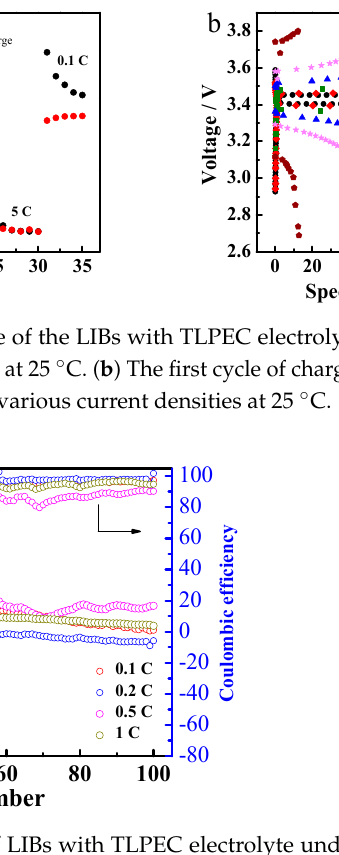
Figure 7. Cycling performances of the LIBs with TLPEC electrolyte at 25 and 60 °C. The charge and discharge current density was 1 C.